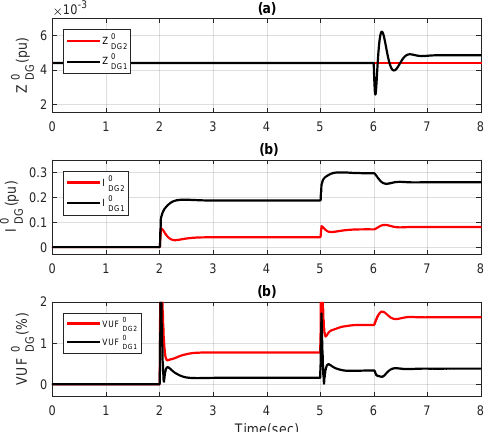
Figure 11. Zero-sequence ( a ) output impedance, ( b ) current, and ( c ) VUF of DG